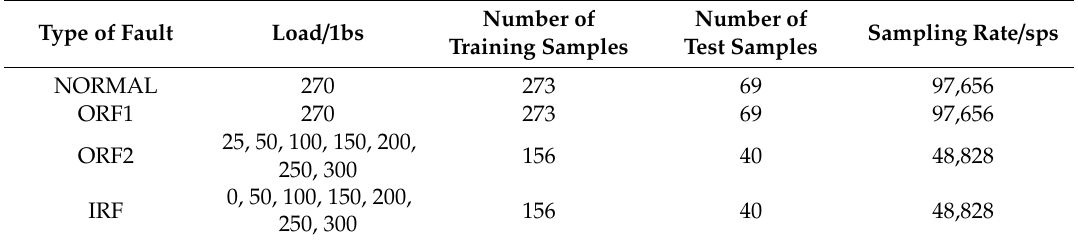
Table 9. Training set and Testing set of mechanical fault prevention technology